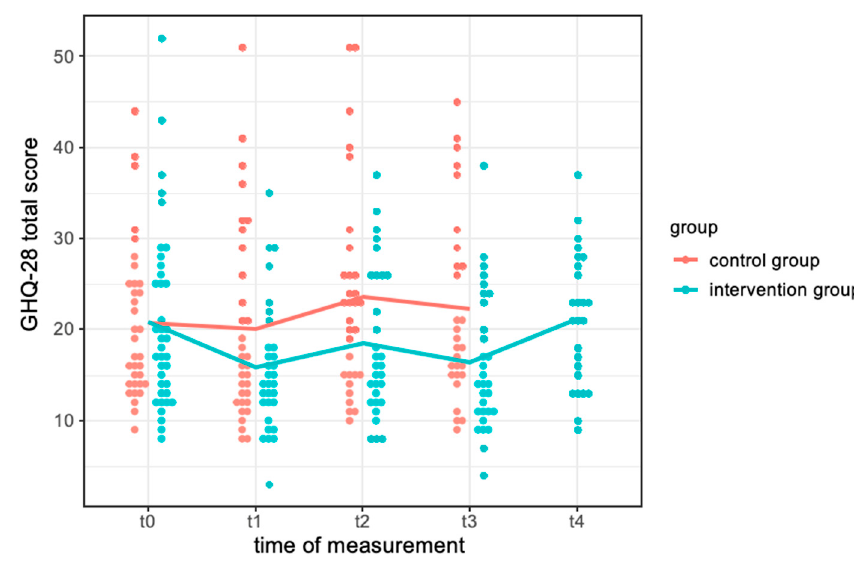
Figure A2. Trend lines for the mental health outcome separately for both groups.